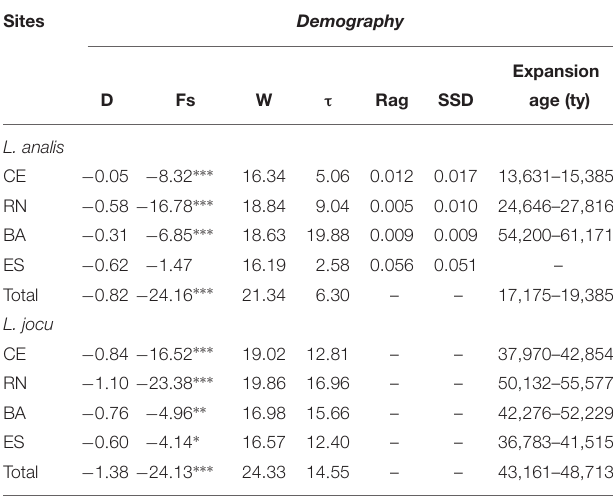
TABLE 5 | Genetic demographic history for populations of Lutjanus analis and Lutjanus jocu , based on mtDNA HVR1 control region sequences variation.